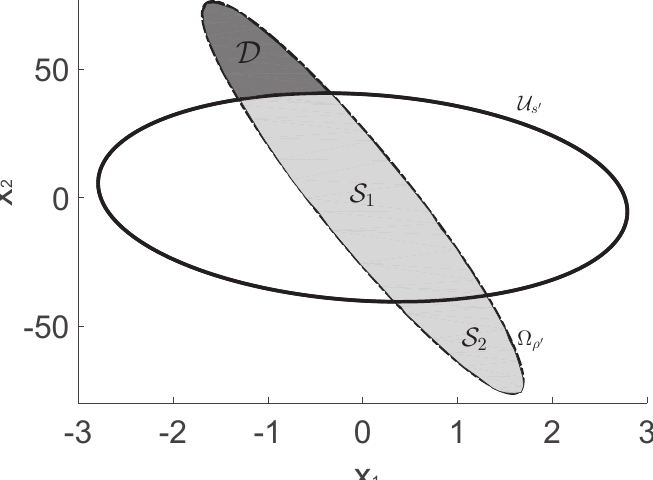
Figure 2. A schematic representing the unsafe region D (dark gray) and the safe operating region S : = S ∪ S 2 (light 1